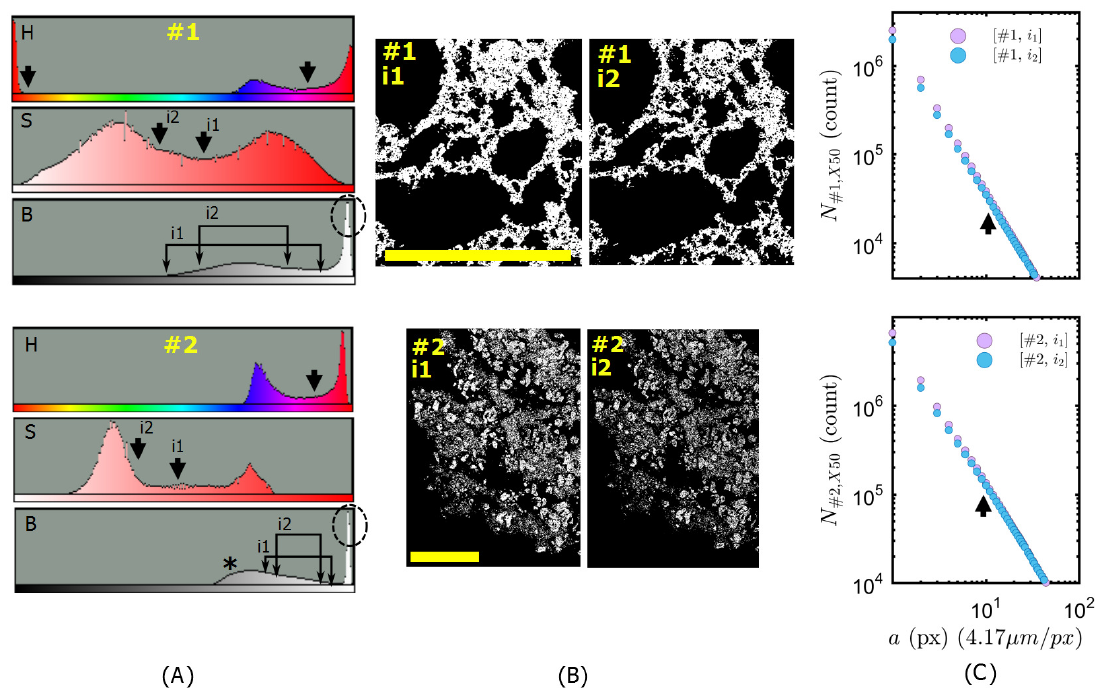
Figure 6. Tresholding histogram peaks at i1 and i2 levels of signal intensity, in order to retrieve specimen skeleton. ( A) Examples of HSB histograms for specimen types #1 and #2. ( B ) Zoomed sections of thresholded binarized recordings. Scale bars represent 5 mm. ( C ) Zoom at box counts: Linear regression, i.e., fractal dimension, remain unchanged down to the resolution indicated by the